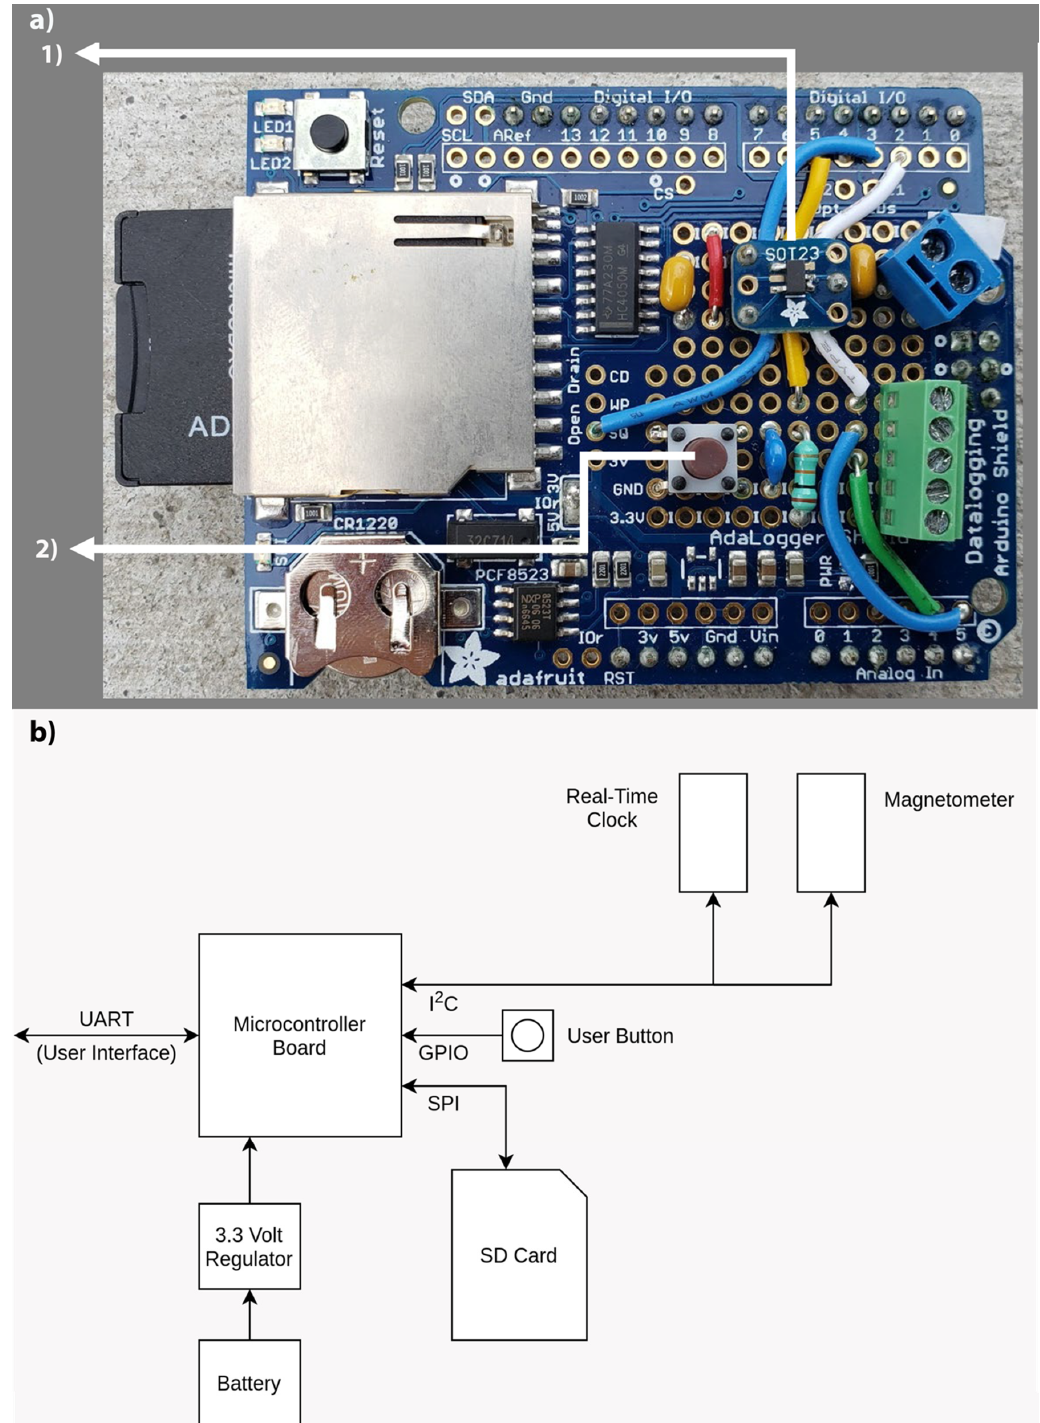
Figure 4. ( a ) Datalogging shield modified for the CIWS datalogger. Main external components added include: (1) more e ffi cient power regulator installed on the Adafruit SOT23 Breakout Pack and (2) wake power button installed to access the user interface when desired. Other modifications and components can be observed in this figure, including the SD card, pin connections described, terminal blocks, resistors, and capacitors added to the shield. ( b ) Block diagram of the connections between main components in the CIWS datalogger. A full diagram of connections is available on the project’s